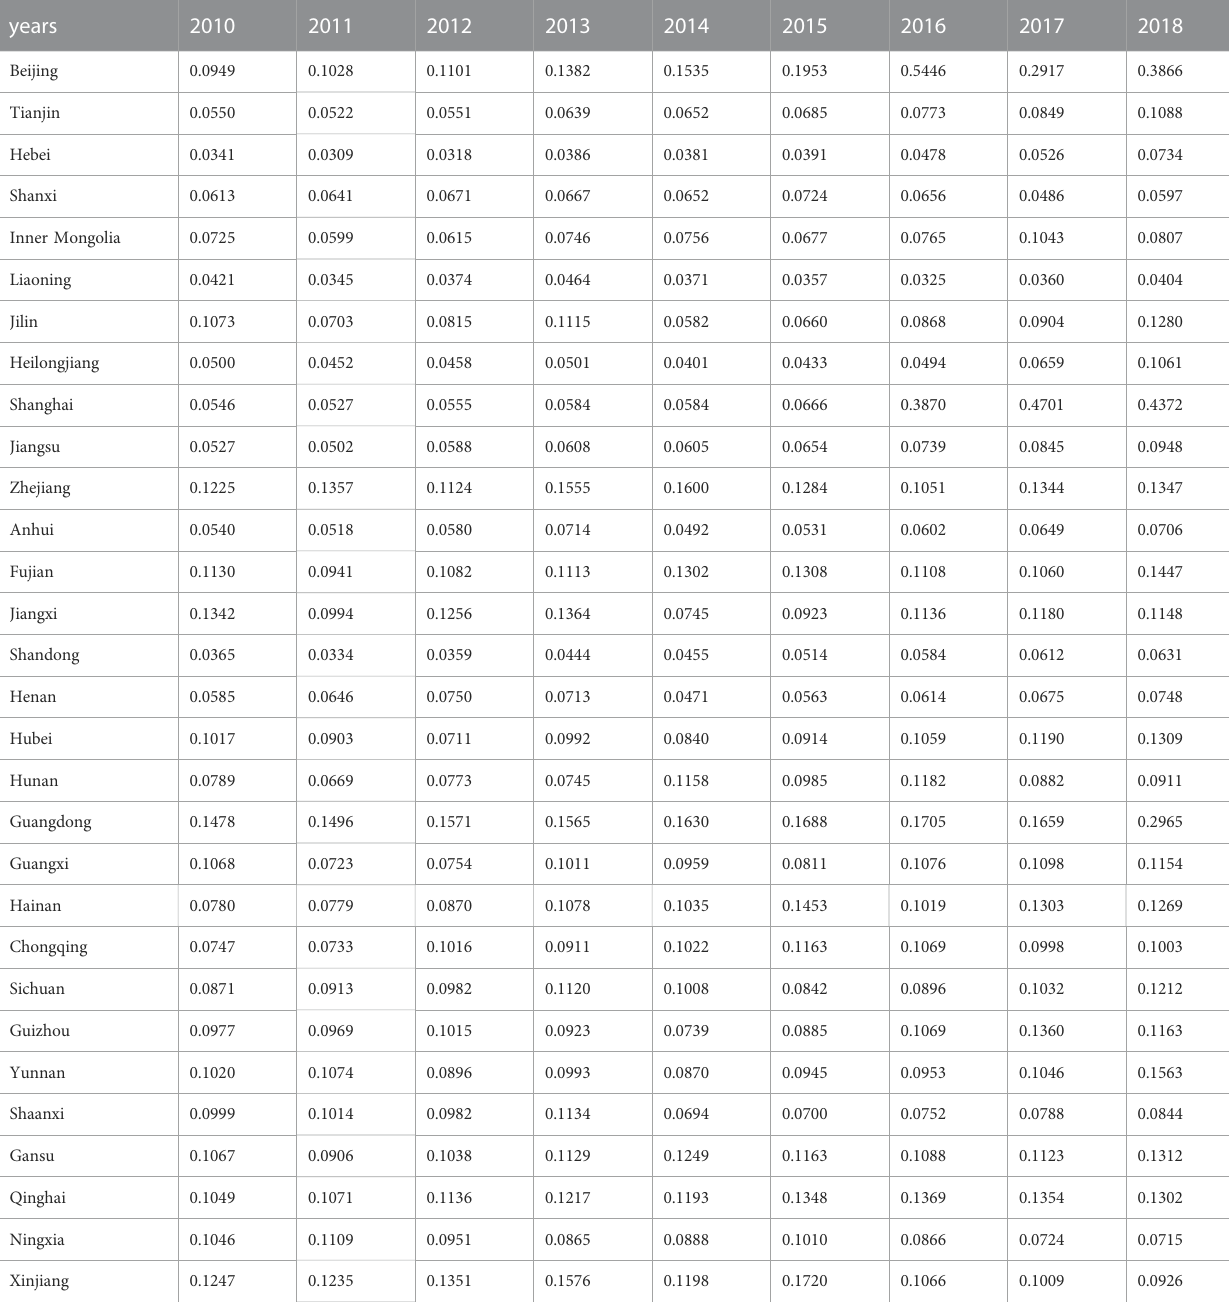
TABLE 2 Measurement results of High-Quality development level of green energy in different regions from 2010 to